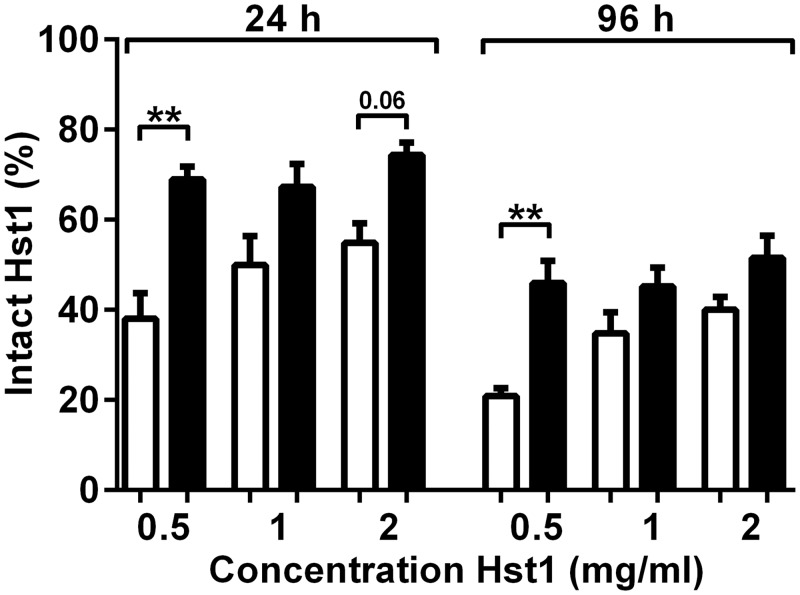
Dose response of Hst1 and PIC in the presence of CWE.Percentage of intact Hst1 remaining after incubation with different dilutions of PIC (1:140 and 1:280) in CWE (1 mg/ml). Starting concentrations of Hst1 were 0.5, 1 and 2 mg/ml. Bars represent means ± SEM of three independent experiments, performed with CWE pools of 5 donors. Black bars = PIC:CWE 1:140 v/v, white bars = PIC:CWE 1:280 v/v. * P <0.05, ** P <0.01.